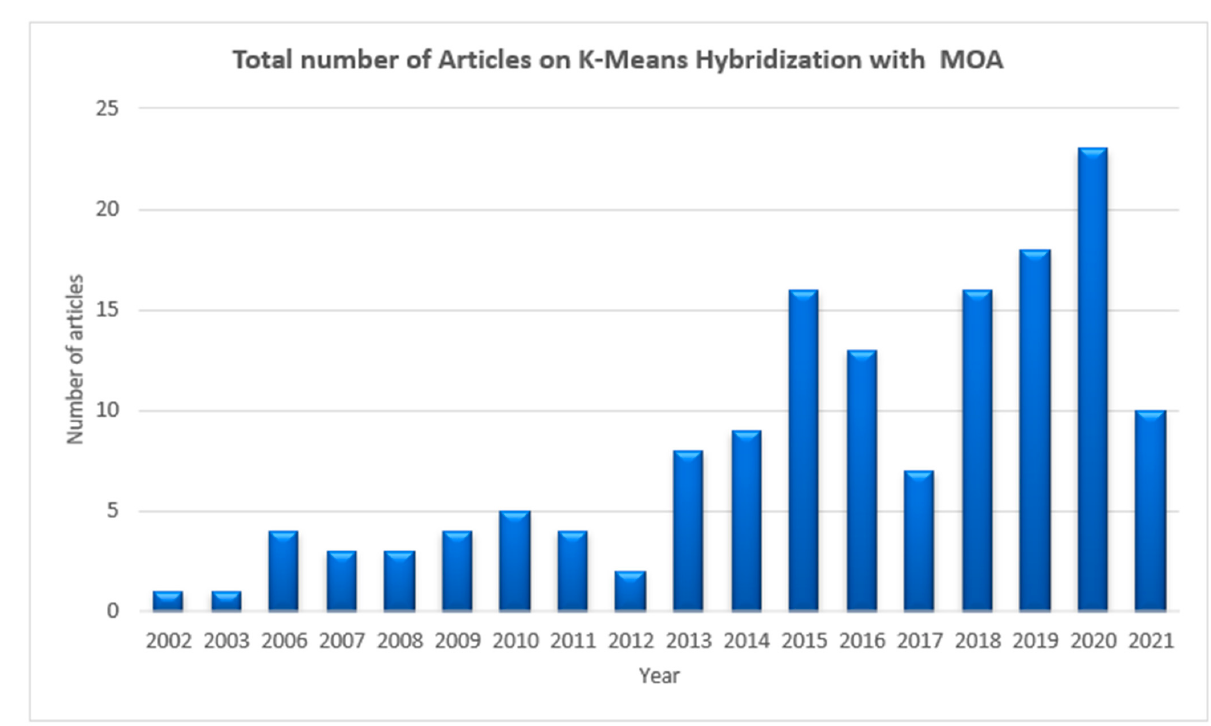
Figure 2. Rate of Publications on K-means hybridization with MOA.